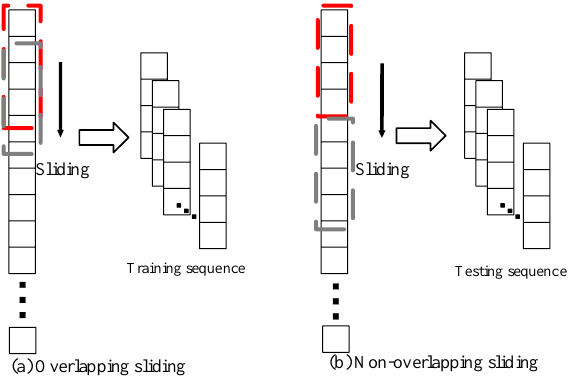
Figure 6. Schematic diagram of sliding processing.